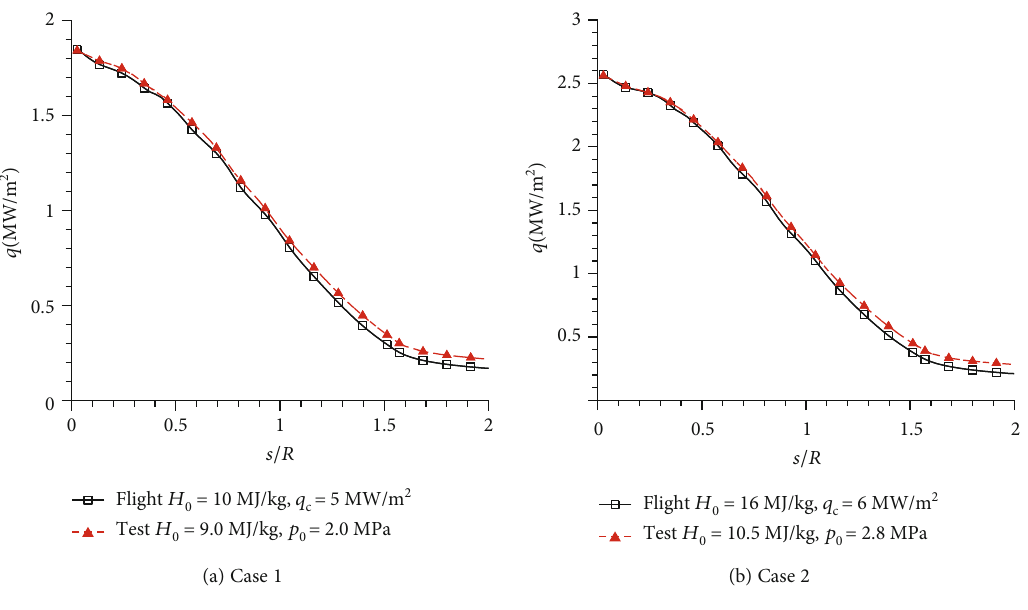
Figure 11: Comparison of the surface heat fl ux on the center line.